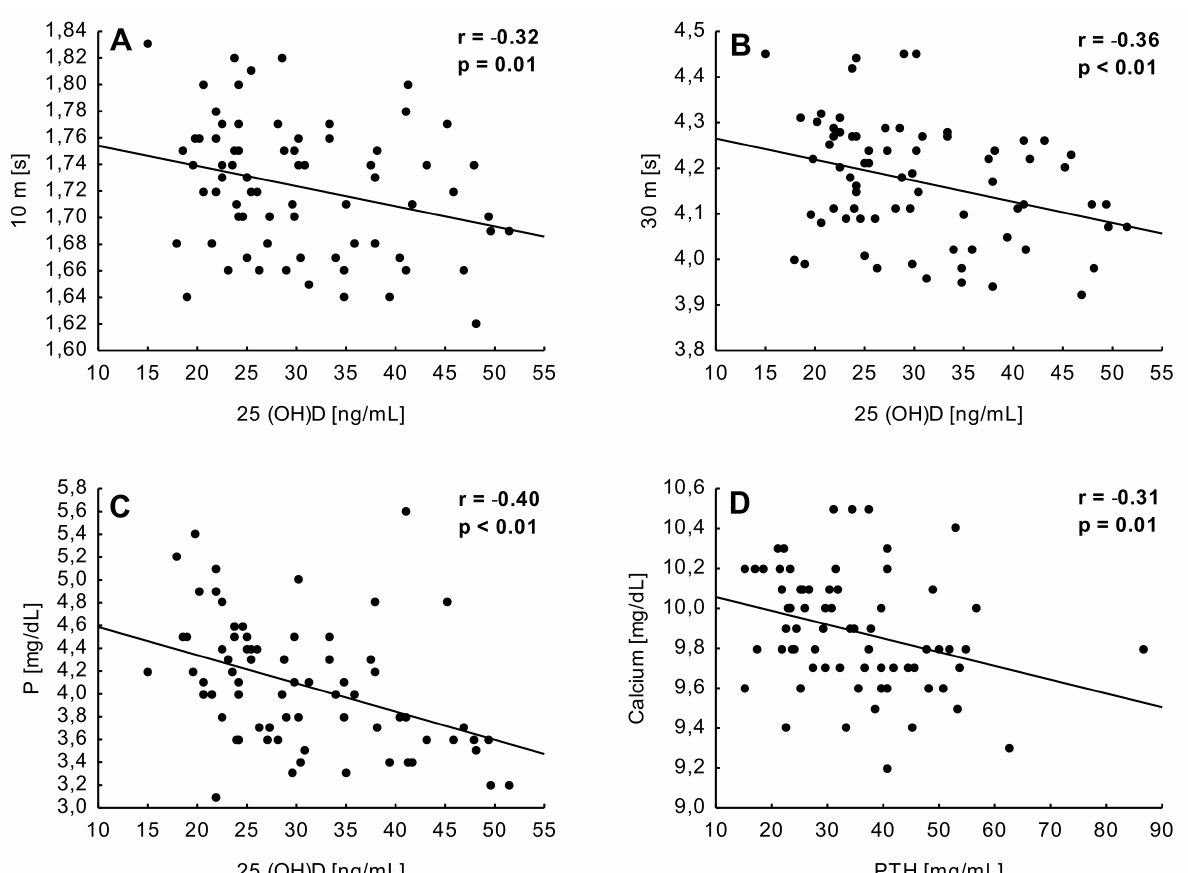
Figure 3. Correlations between chosen blood parameters and sprint test results in tested young soccer players. ( A ) A correlation between 10 m time and 25(OH)D concentration; ( B ) between 30 m time and 25(OH)D concentration; ( C ) between phosphorus (P) and 25(OH)D concentration; ( D ) between calcium and parathyroid hormone